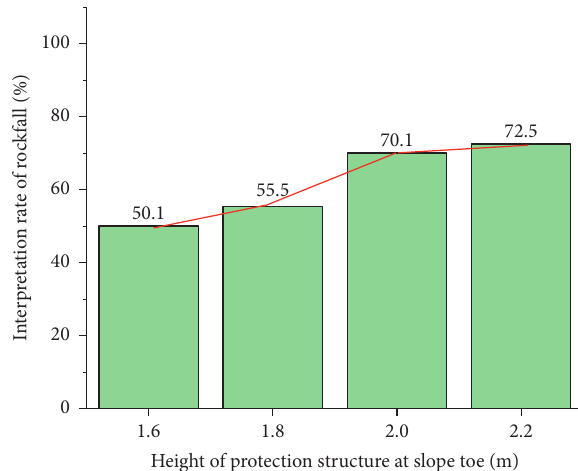
Figure 8: Five protection schemes for the rockfall interception rate.